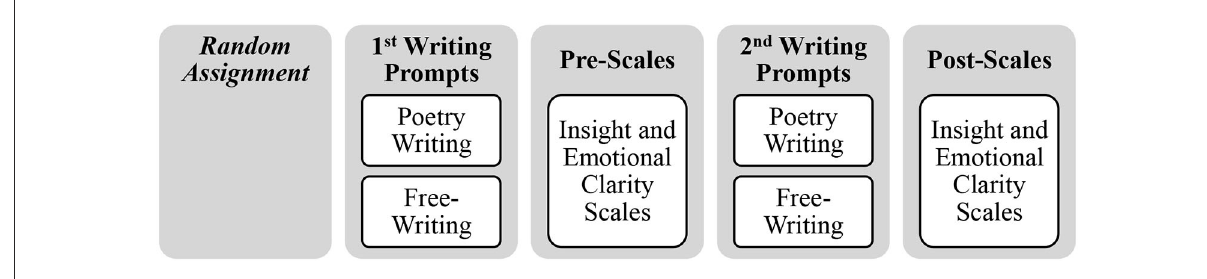
FIGURE1 Schematic presentation of data collection and directed writing process design.